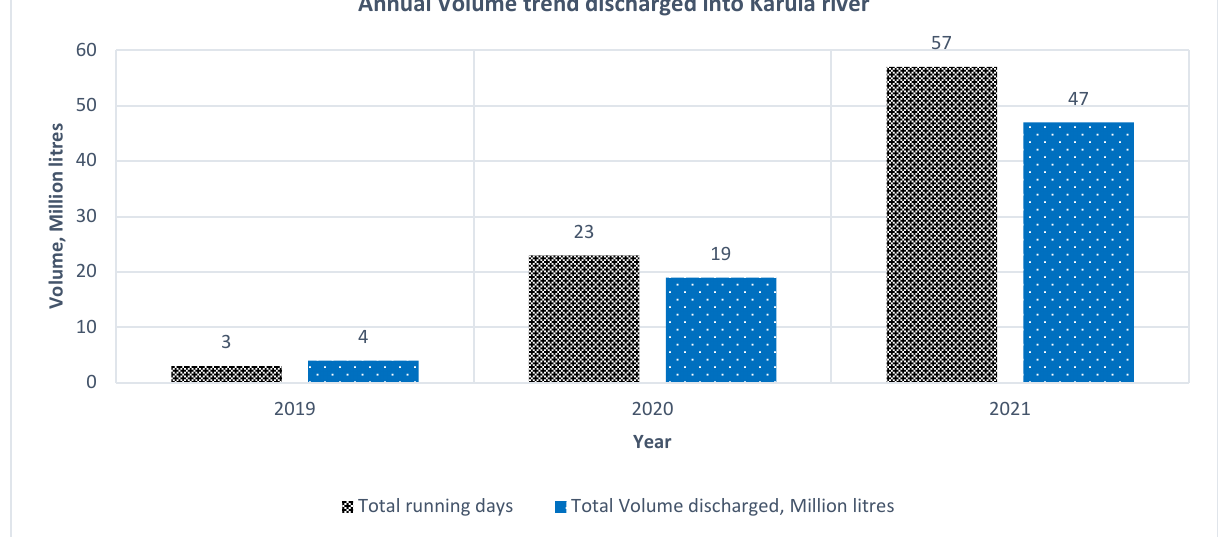
Figure 5. The annual volume of saved water released into the river along with number of days in a year when releases are made into the river.